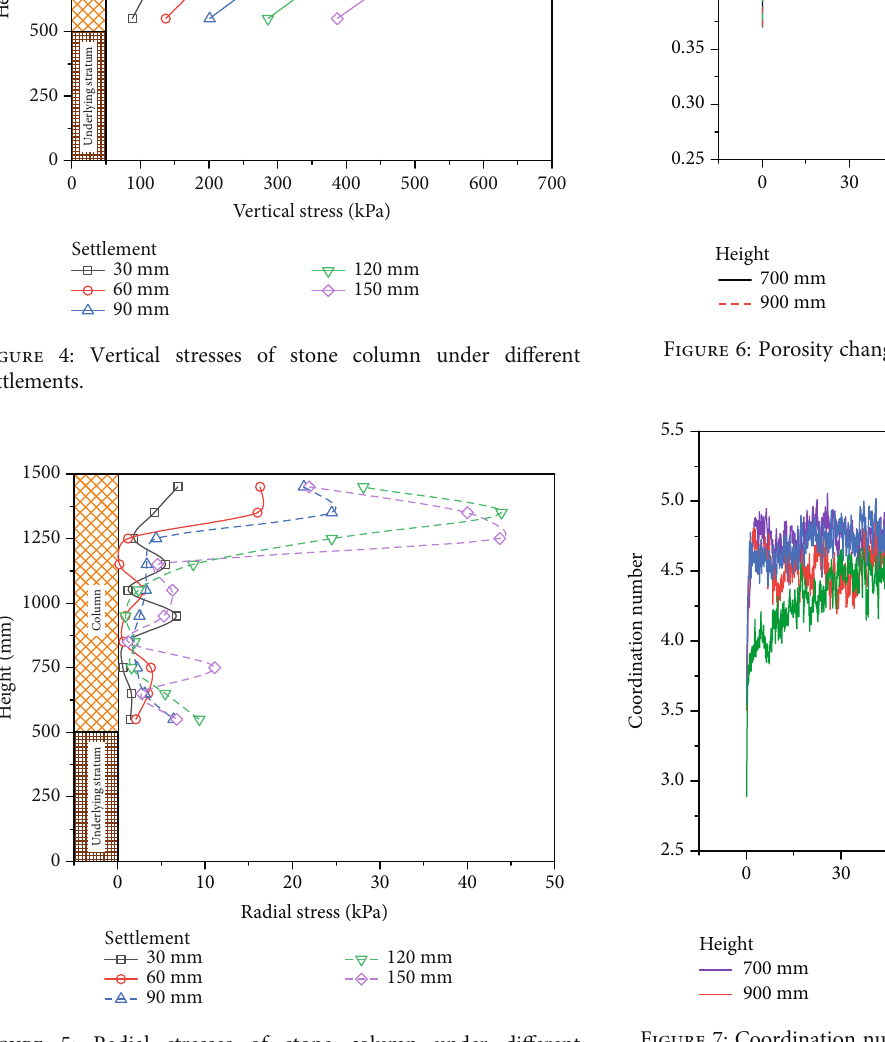
Figure 5: Radial stresses of stone column under di ff erent settlements.